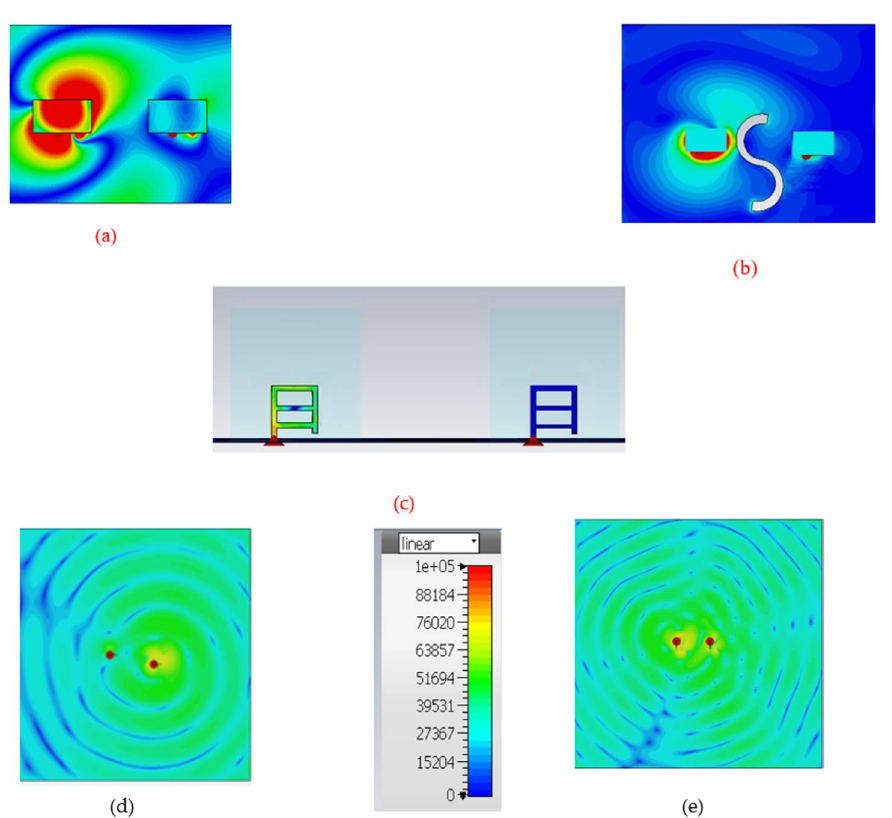
Figure 11. ( a ) Surface wave current before deputing DGPS (top view) at 3.89 GHz; ( b ) Surface wave current after deputing DGPS at 3.89 GHz (top view); ( c ) Surface wave current after deputing DGPS at 3.89 GHz (front view); ( d ) Surface wave current on the ground plane before deputing DGPS at 3.89 GHz (counterclockwise); and ( e ) Surface wave current on the ground after deputing DGPS at 3.89 GHz (co-centric).